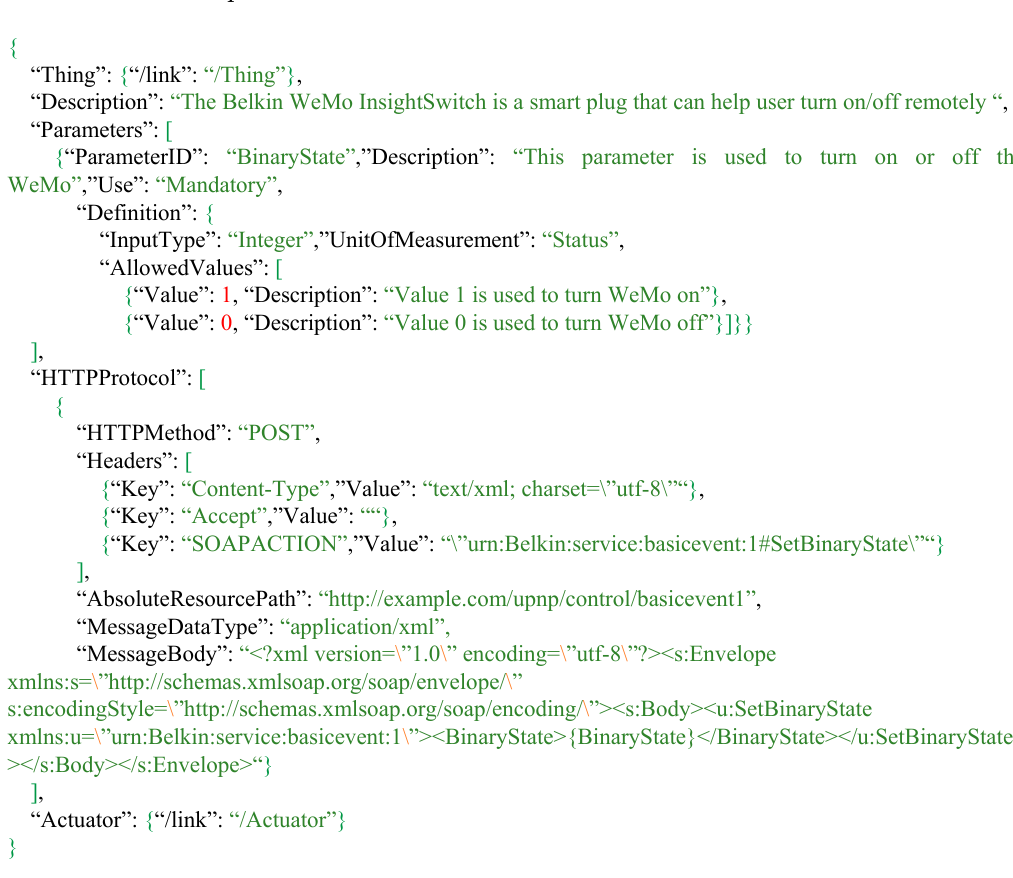
Figure 11. The tasking capability description of Belkin WeMo.